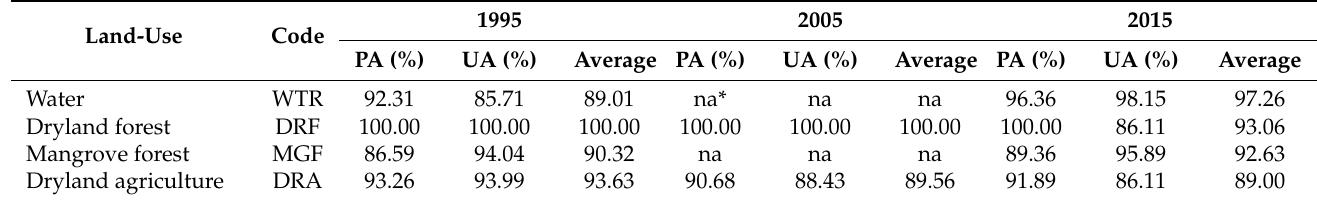
Table A2. Accuracy Assessment for Classified Images of BRB 1995, 2005, and